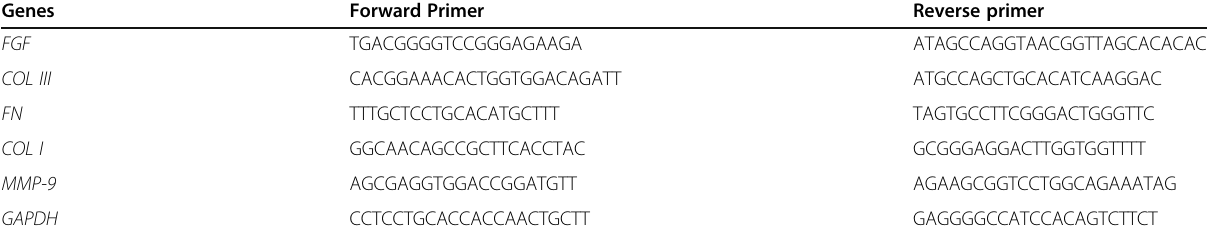
Table 1 Primers sequences (nucleotide sequences) used during quantitative RT-PCR Genes Forward